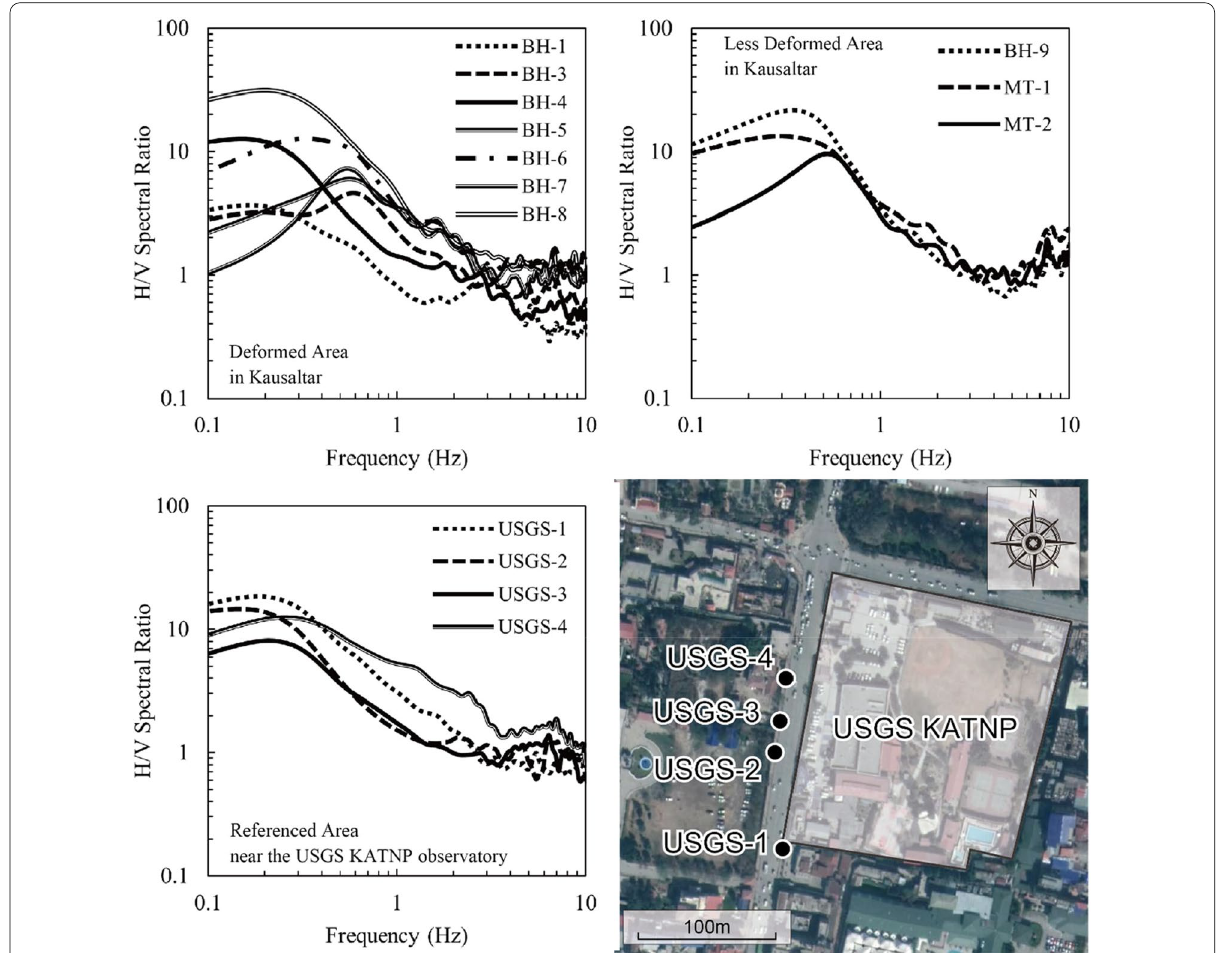
Fig. 4 Microtremor H/V spectra at the observation sites in the undeformed area, the less-deformed area in Kausaltar, and near the KATNP observatory